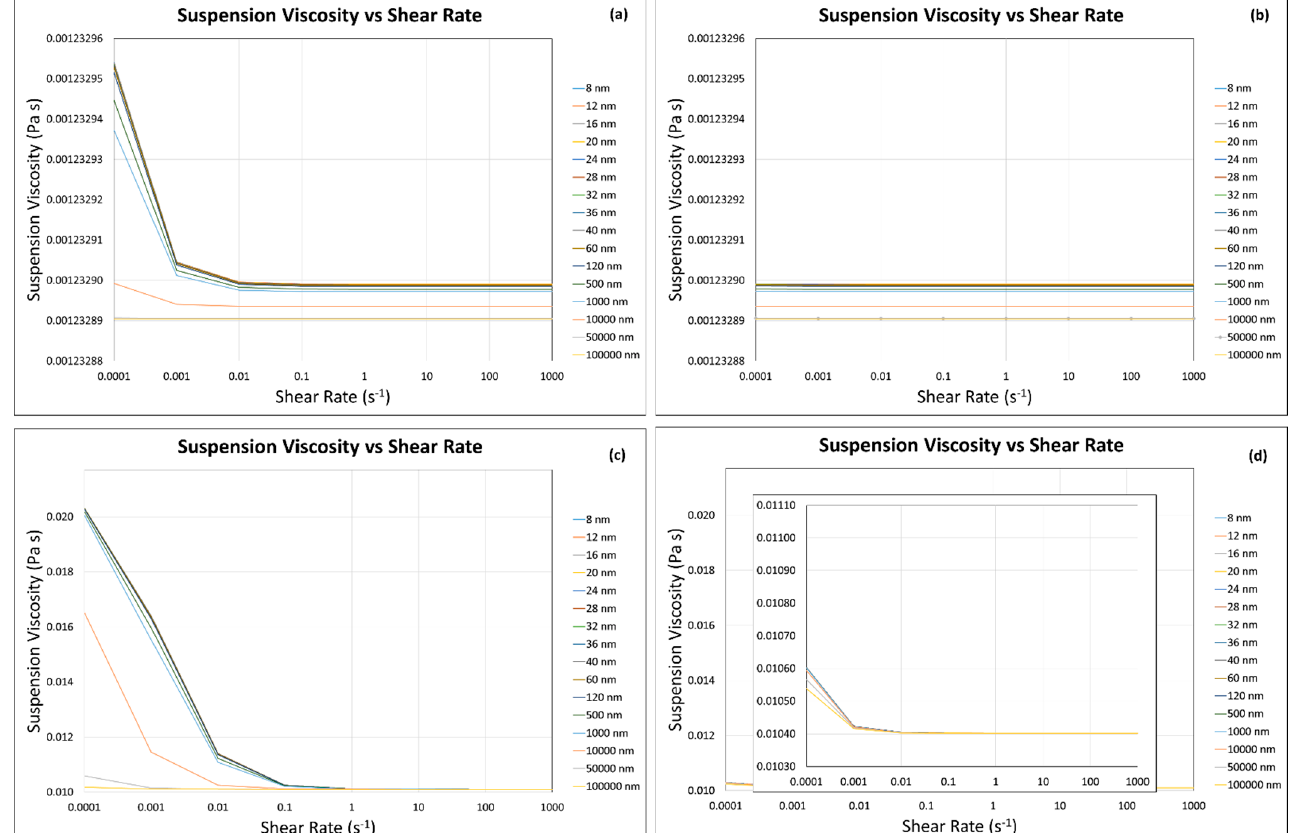
Figure 6. Viscosity of quartz particle suspension as a function of shear rate by a predictive model, ( a ) φ = 0.1, a 1 : a 2 = 1 : 9, ( b ) φ = 0.1, a 1 : a 2 = 9 : 1, ( c ) φ = 0.5, a 1 : a 2 = 1 : 9, and ( d ) φ = 0.5, a 1 : a 2 = 9 : 1. Note: the major y-axis of subfigure ( d ) is made for the purpose of Table 3. DLVO total potential energies between coarse (80 μ m) and fine/ultra-fine particles at dif- ferent solid fractions and particle sizes for the same quartz particles with different particle sizes.